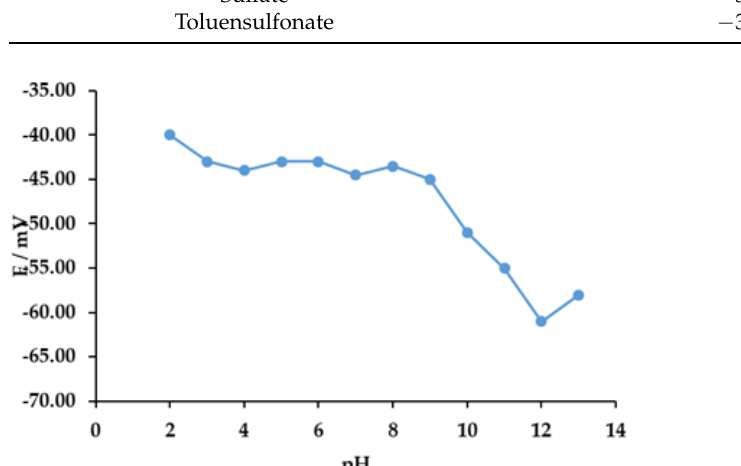
Figure 3. The response characteristics of DODI–TPB surfactant sensor towards SDS (0.5 mM) in deionized water at different pH